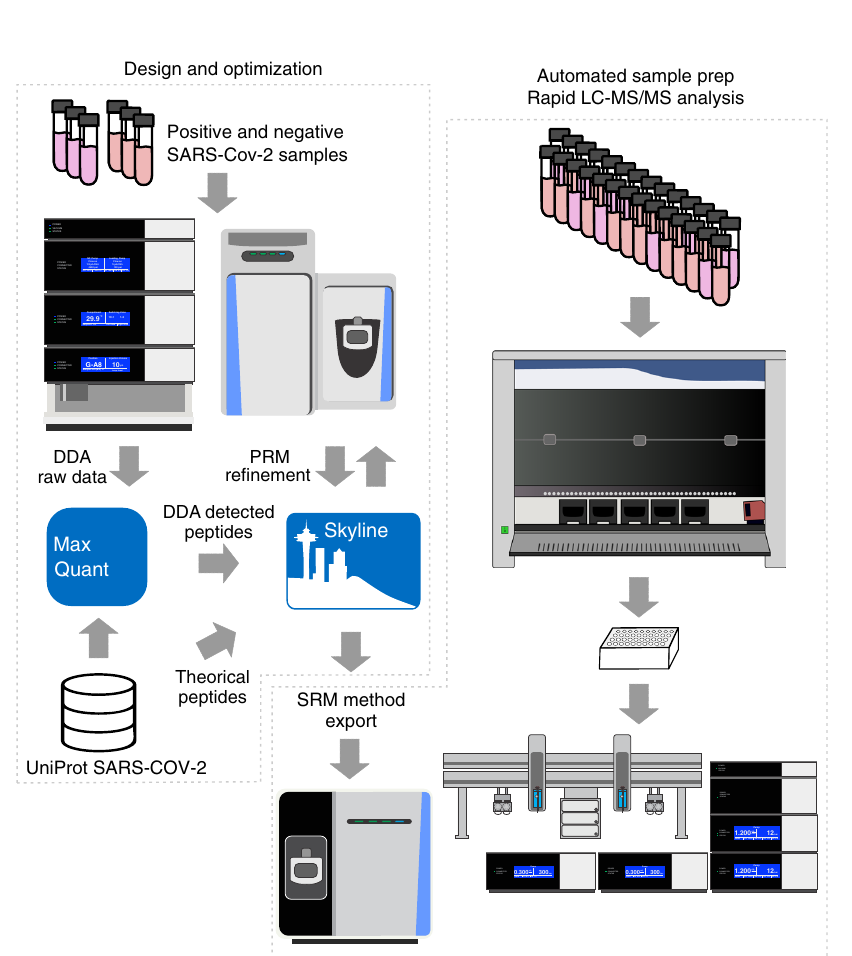
Fig. 1 Test development work fl ow. Design and optimization: peptide selection was performed by analyzing tryptic extracts from patient samples previously de fi ned as positive or negative for SARS-CoV-2 by real-time RT-PCR. Data-dependent acquisitions (DDA) were achieved by micro fl ow chromatography coupled to hybrid quadrupole-orbitrap tandem mass spectrometry. Skyline was used to generate the isolation list for parallel reaction monitoring (PRM). Several PRMs were performed before selection of the fi nal two peptides that were exported as selected reaction monitoring (SRM) coordinates to a triple quadrupole tandem mass spectrometry. Automated sample prep/rapid LC-MS/MS (liquid chromatography coupled to tandem mass spectrometry) analysis: sample preparation was optimized, aiming for simplicity and speed and was fully implemented in a robotic liquid handler. Multiplexed four-channel analysis resulted in a 2.5-min acquisition time per